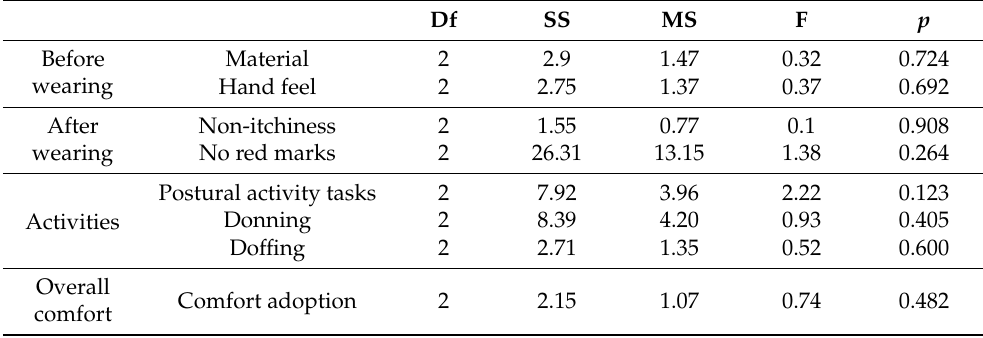
Table 5. One-way ANOVA summary table comparing comfort assessment between participant groups (control, copers, and chronic ankle